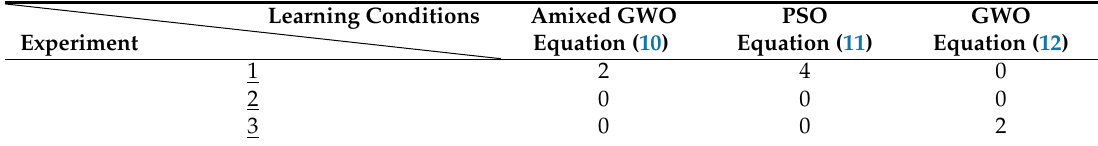
Table 8. Number of missclassified images out of 54 images for various system configurations and testing